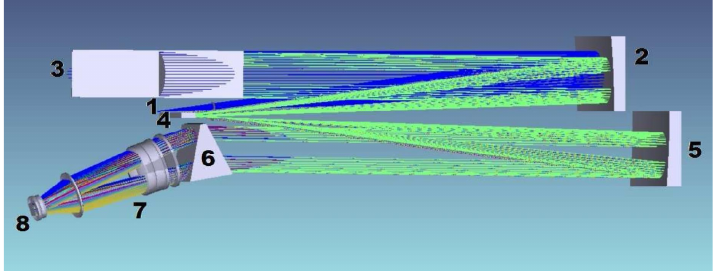
Figure 6. Optical scheme of the